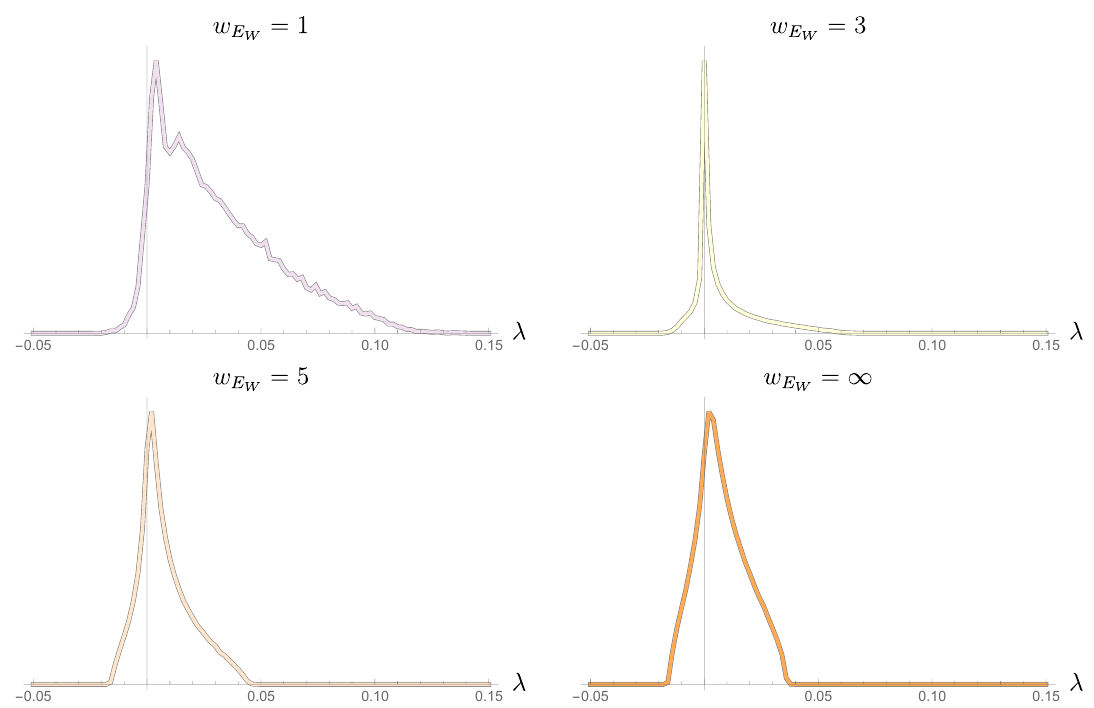
and keep w = 1 , A W